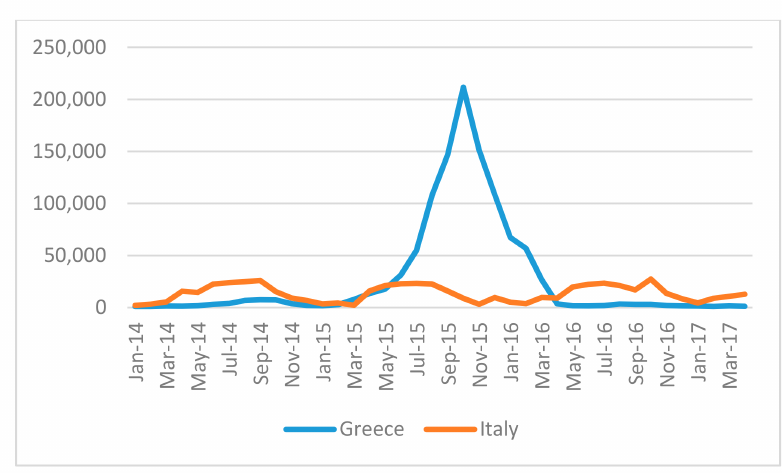
Figure 1. Sea Arrivals in Greece and in Italy. Source: UNHCR/National Authorities in Italy and